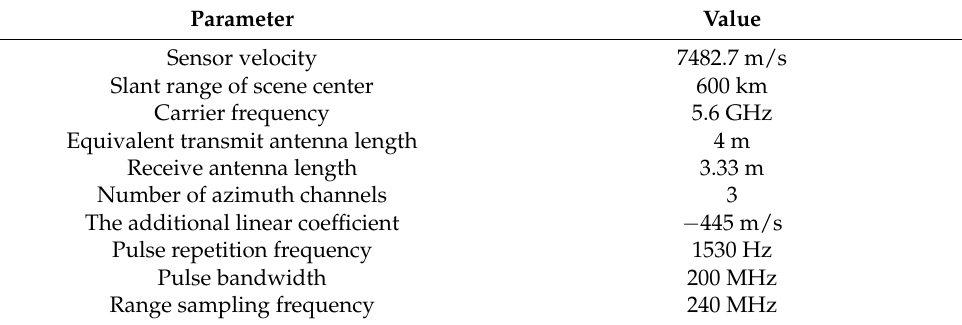
Table 1. Simulation